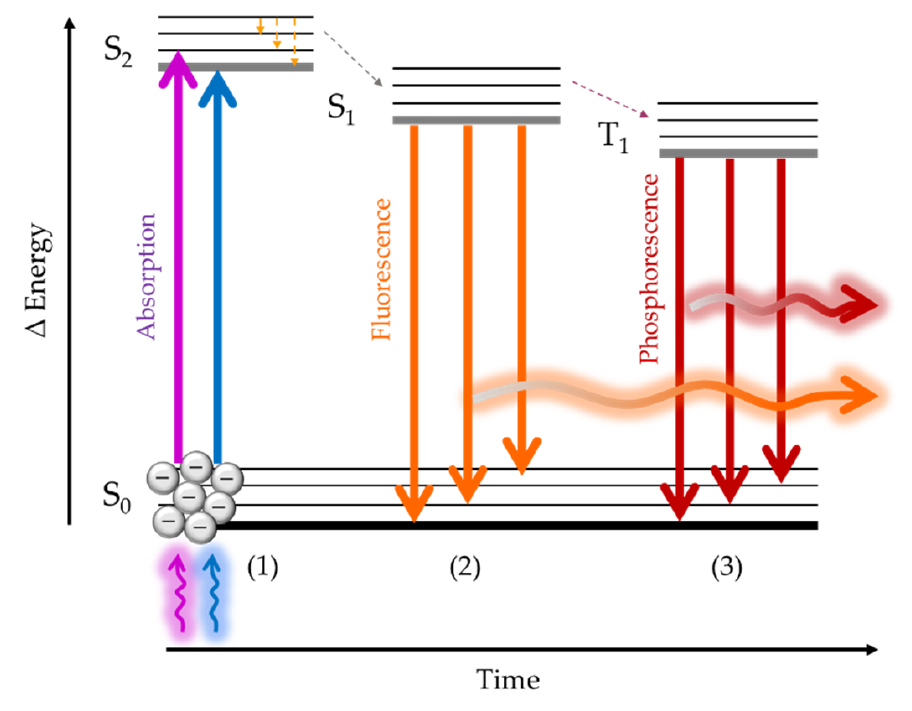
Figure 2. Schematic of a Jablonski’s diagram showing the two kinds of luminescence. Furthermore, the luminescent intensities and lifetimes of some luminophores depend on the presence of certain analytes or on the conditions of the surrounding media [28], so they are of great interest for the development of optical biosensors. This can be done by attaching the luminophores to the bioreceptor [29,30] or to the target analyte [31]. In some cases, it is the binding between the bioreceptor and the analyte that induces changes in the surrounding medium of the luminophore [28]. This normally leads to quenching or enhancement processes (i.e., shorter or longer lifetimes). Another possibility is to label the analyte with a luminophore, so when it joins the bioreceptor, the luminescent emission can be captured. Therefore, luminescence quenching as well as luminescence enhancement biosensors can be developed. To the first group belong all the sensors whose intensity decreases in the presence of the target analyte. In the second case, the opposite phenomenon takes place: the luminescent emission increases due to the presence of the target analyte. Figure 3 shows the working principle of a luminescence quenching-based optical fiber biosensor. The fiber is first functionalized with a luminophore-labelled bioreceptor (a) that is illuminated at the absorption wavelength of the luminophore (b). As the target analyte concentration (C i ) increases, the luminophores are quenched (c), so the emitted intensity (I i ) decreases (d). The dynamic response of the sensor is depicted in Figure 3e, whereas the obtained calibration curve is shown in Figure 3f. In the case of luminescence enhancement sensors, the opposite process occurs: as the analyte concentration increases, so does the luminescent emission. Only the first process is shown for